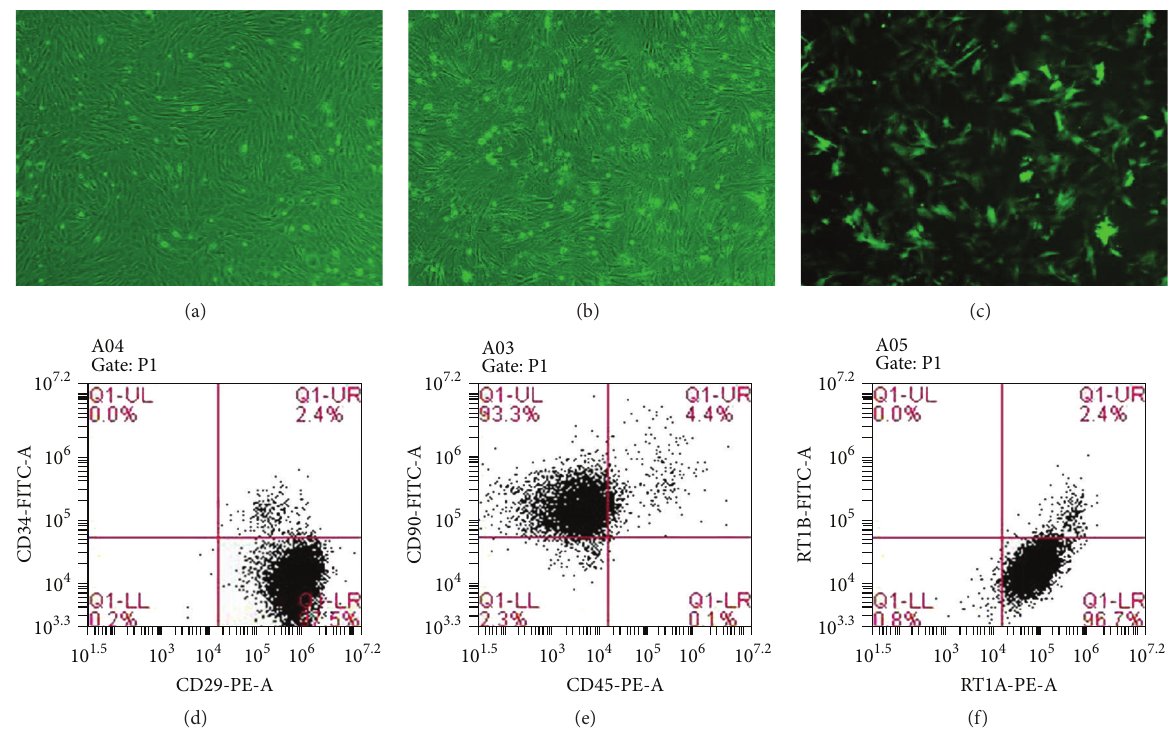
Figure 1: Morphological (100x) and flow cytometric analysis of BMMSCs. (a) Morphology of third-passage BMMSCs. (b) Morphology of BMMSCs after transduction with HO-1 in a bright field. BMMSCs exhibited spindle-shaped morphology and were arranged in whorls when transfected with HO-1. (c) Morphology of BMMSCs after transduction with HO-1 in a fluorescent field. Over 85% of BMMSCs after transduction with HO-1 emitted green fluorescence. (d) The proportion of CD29-positive and CD34-negative cells was 97.5%. (e) The proportion of CD90-positive and CD45-negative cells was 93.3%. (f) The proportion of RT1A-positive and RT1B-negative cells was